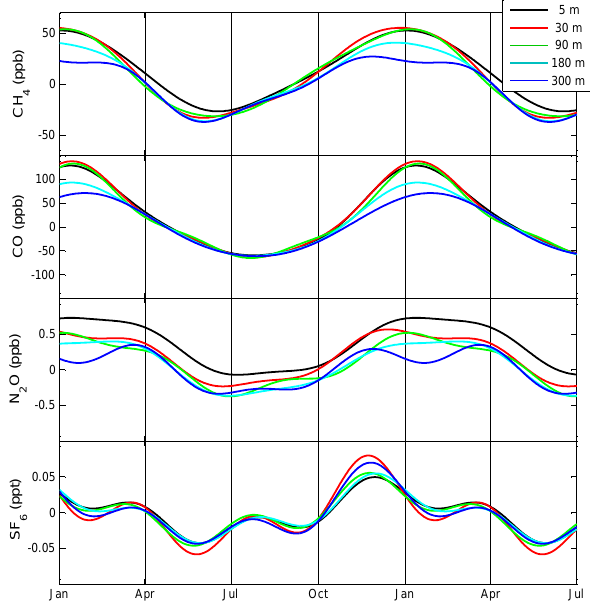
Fig. 7. Seasonal cycles of CH 4 , CO, N 2 O and SF 6 . The colours represent different sampling